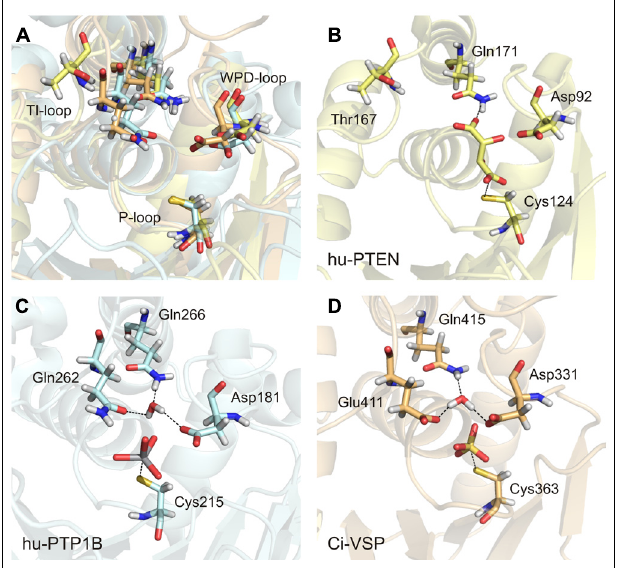
FIGURE 6 |An activated water molecule is required for the second step in catalysis of class I PTPs. (A) The substrate binding pocket is structurally aligned for the human PTP1B (in light blue, PDB accession number 3ib0), human PTEN (in yellow, PDB 1d5r), and Ci-VSP [in orange, modeled by MD simulation based on the crystal structure of Matsuda etal. (2011) and Hobiger etal. (2013) PDB 3awe].The glutamines from theTI-loop of hu-PTP1B and the corresponding amino acids in the other PTPs, the invariant aspartate from theWPD-loop, and the catalytic cysteine from the P-loop are represented as sticks. (B–D) The substrate binding pockets are shown individually for the three PTPs with the following ligands bound to the active site, as found in the respective crystal structures: L( + )-tartrate in hu-PTEN, vanadate in hu-PTP1B, and sulfate in Ci-VSP. One water molecule is coordinated adjacently to the aspartate and the ligand by theTI-loop glutamines in hu-PTP1B (C) and by corresponding residues in Ci-VSP (D) . (B) This water molecule is absent in hu-PTEN.Thr167 that corresponds to Gln262 in hu-PTP1B and Glu411 in Ci-VSP is oriented away from the active site. One of the oxygen atoms of the bound tartrate forms a hydrogen bond with the nitrogen of